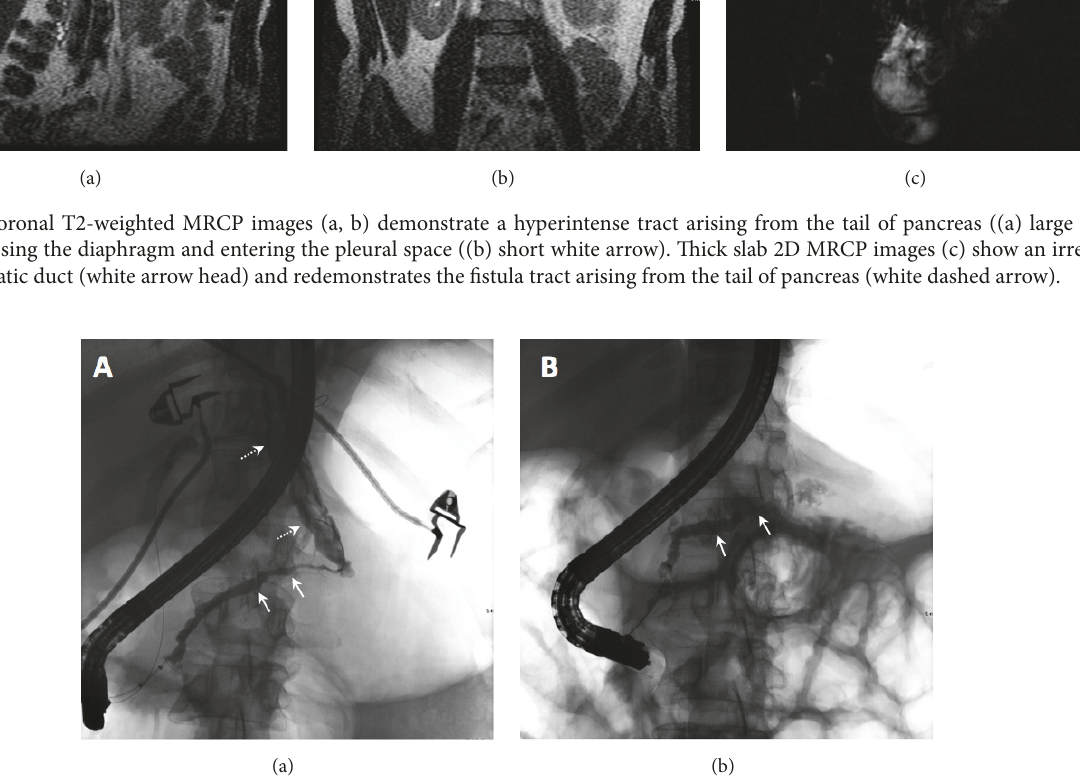
Figure 4: ERCP at admission (a) shows mild diffuse dilatation of ventral pancreatic duct involving the head, body, and tail of the pancreas (white arrows) with pancreatic duct leak in the most upstream tail of the pancreas that extends caudally to the pleural cavity (dashed white arrows). A follow-up ERCP after treatment (b) demonstrates mild diffuse dilatation of the main pancreatic duct with resolution of the fistula